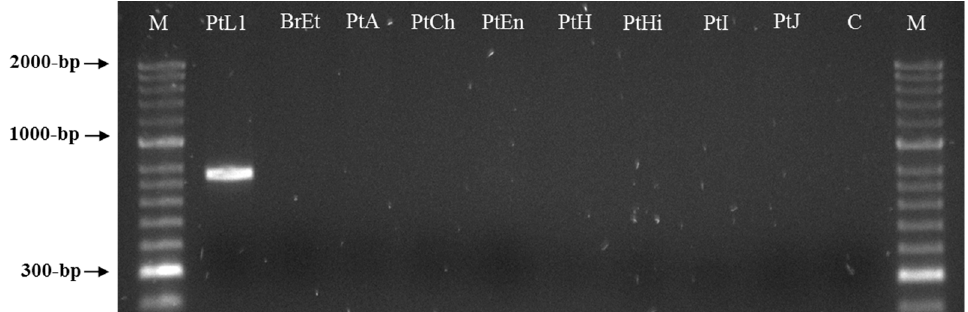
Figure 4. SCAR-PCR product (~770 bp specific fragment) for Meloidogyne luci (isolate PtL1) and other Meloidogyne species (isolates BrEt, PtA, PtCh, PtEn, PtH, PtHi, PtI, PtJ), included in the study, using the species-specific primer pair Mlf/r. For isolate codes see Table 1. M—DNA marker (HyperLadder II, Bioline); C—Negative control.